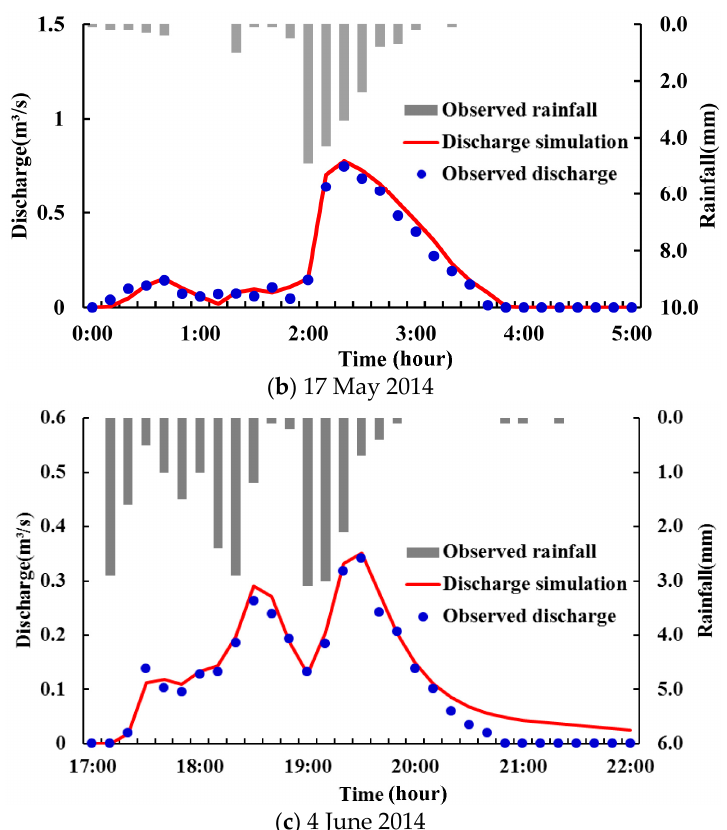
Figure 2. The observed and simulated hydrographs.